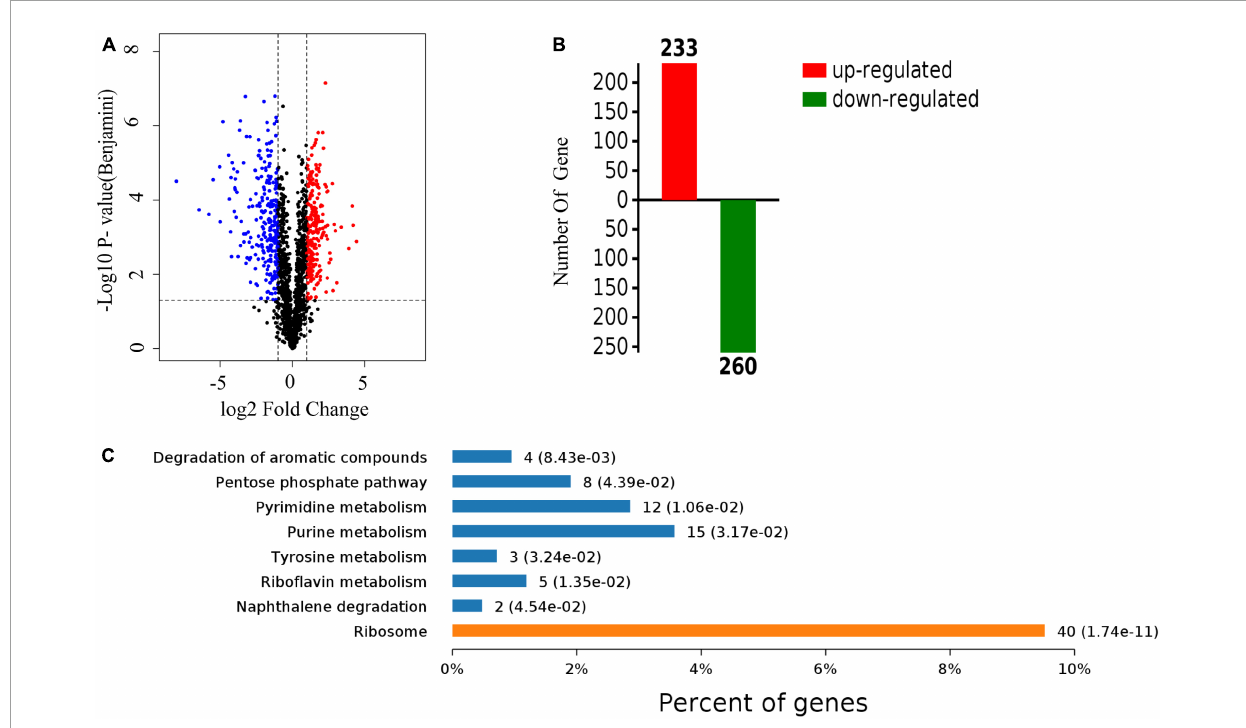
FIGURE5 The proteomic analysis of S. aureus treated with radezolid. (A) Volcano plots show the comparison of the proteomic analysis of S. aureus treated with radezolid (1/8 × MIC). Blue dots represent the decreased levels of S. aureus proteins caused by radezolid exposure. Red dots represent the upregulated levels of S. aureus proteins caused by radezolid exposure. The P -value was calculated using a two-sided, two-sample t -test; three independent experiments were performed per group. The data of the protein expression levels were calculated from the average value. (B) A number of differentially expressed proteins in S. aureus with radezolid and control, respectively. (C) KEGG pathway in S. aureus with radezolid and control, respectively.